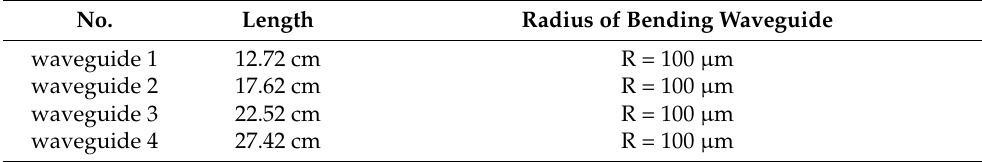
Table 3. Structural parameters of the bending waveguides.